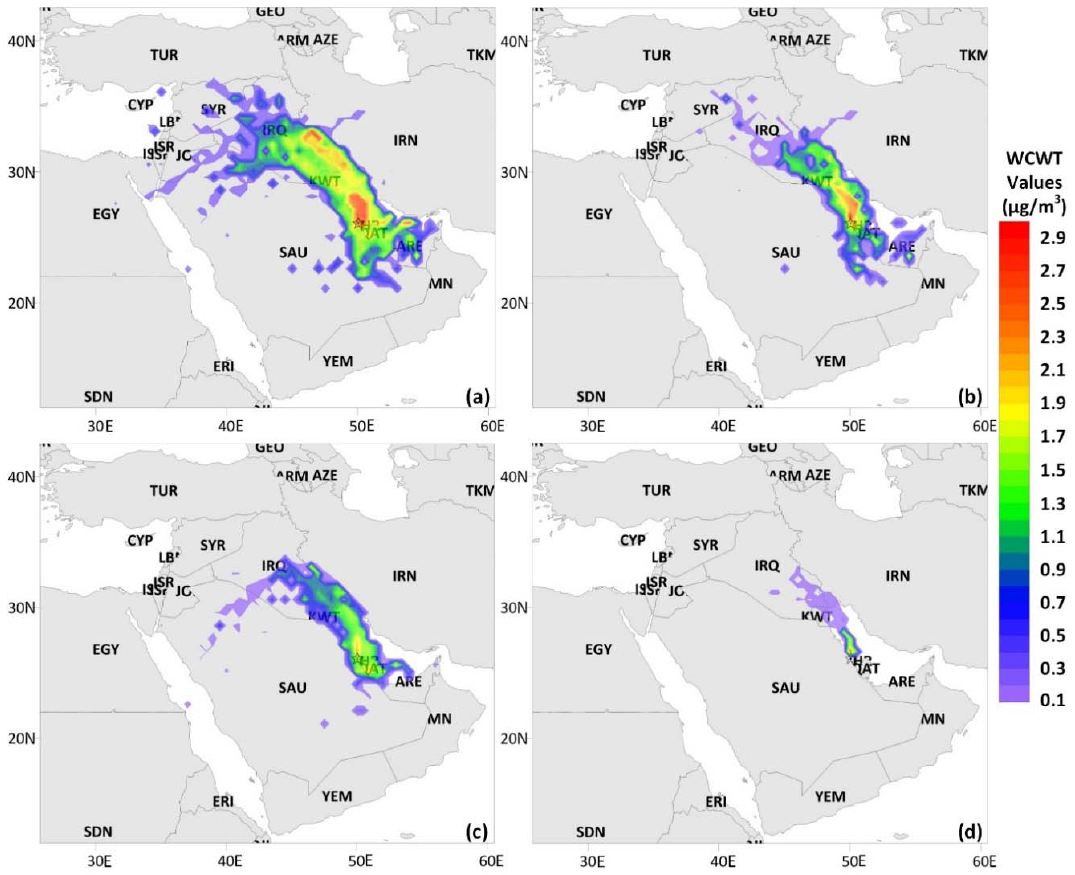
Figure 7. Concentration-weighted trajectory (CWT) analysis results for: ( a ) the whole study, ( b ) Pre-LD, ( c ) LD, and ( d ) Post-LD stages.